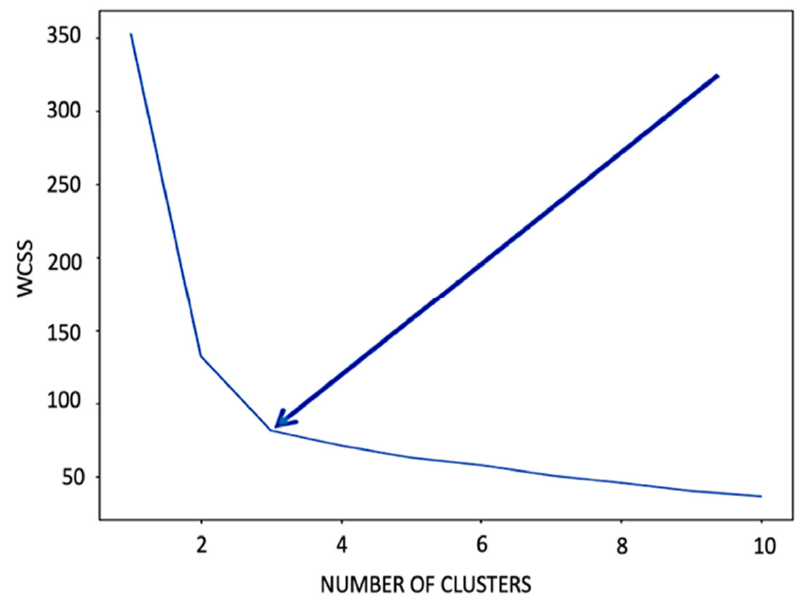
Figure 8. Application of the elbow method to determine the optimal number of clusters.